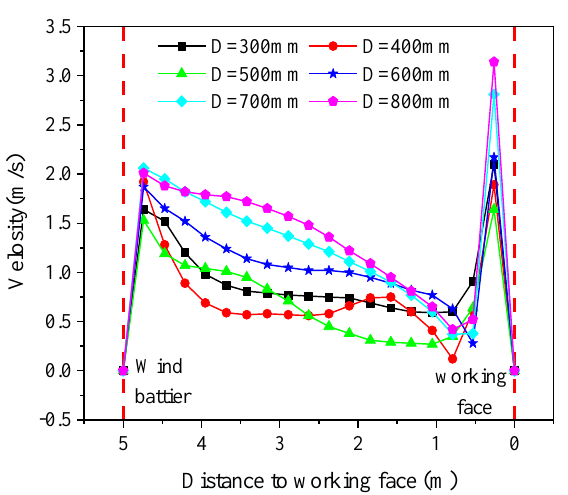
Figure 8. The velocity distribution of the working centerline under different air supply pipe.